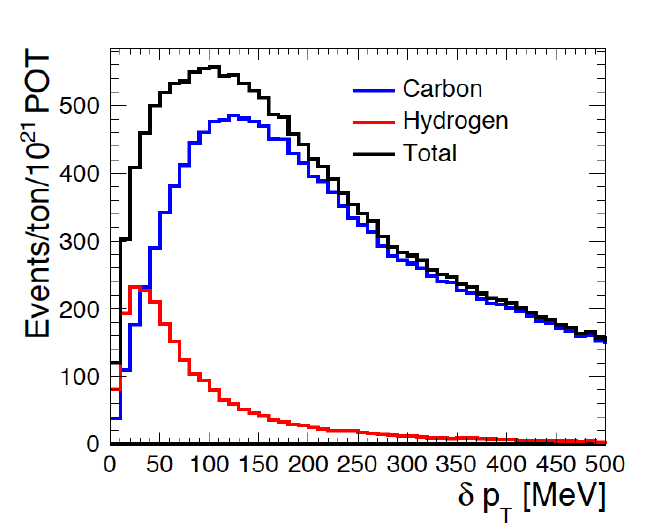
Figure 139. The NEUT 5.4.0 predicted event rate of antineutrino CC with no pions in the final state as a function of the missing transverse momentum in 3DST. The figure is taken from